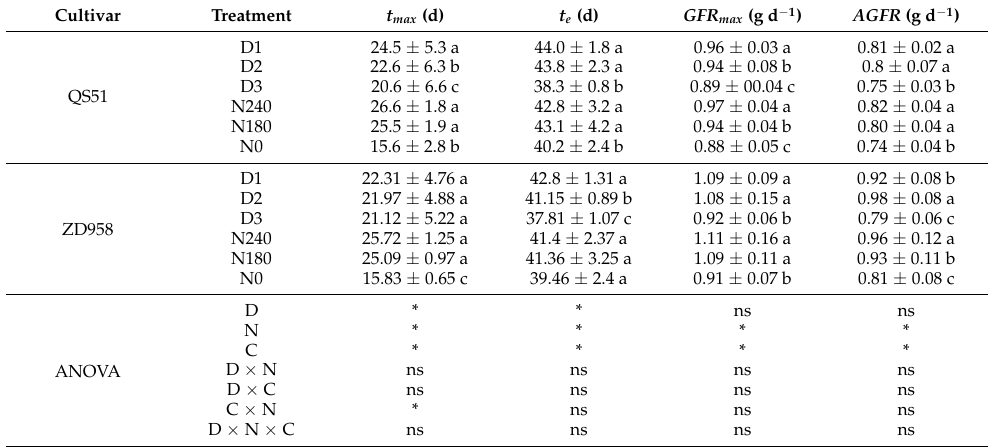
Table 1. Analysis of variance of maize grain-filling characteristics parameters under different planting densities and nitrogen rates for QS51 and ZD958.